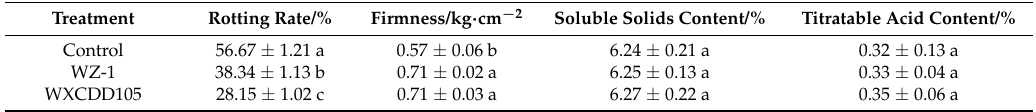
Table 7. Effects of different treatments on fruit quality of